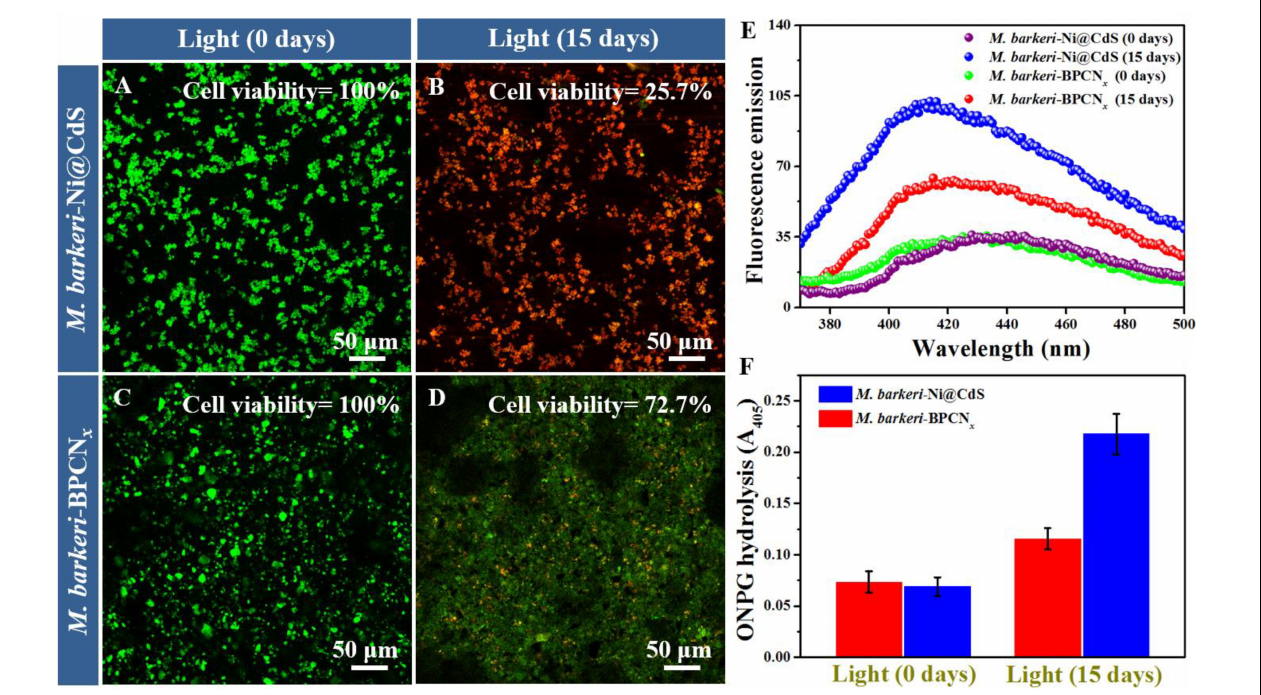
FIGURE 5 | Characterizedactivity of M. barkeri -Ni@CdS and M. barkeri -BPCN x . (A–D) CLSM images of M. barkeri -Ni@CdS and M. barkeri -BPCN x . (E) Fluorescence intensity of the NPN of M. barkeri -Ni@CdS and M. barkeri -BPCN x . (F) ONPG hydrolysis absorbance of M. barkeri -Ni@CdS and M. barkeri -BPCN x .